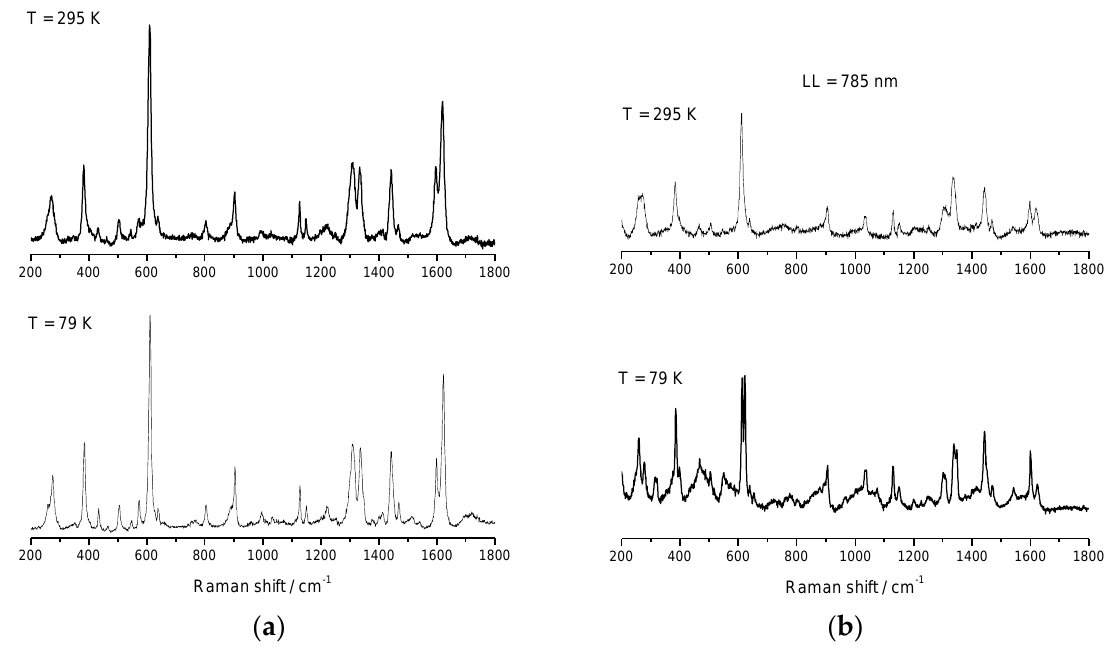
Figure 9. Variable temperature rRaman spectra of [FeL 1C6 ]BF 4 , 1 , using laser ex 532 nm ( a ) and variable temperature Raman spectra of [FeL 1C6 ]BF 4 , 1 , using laser excitation of 785 nm ( b ).